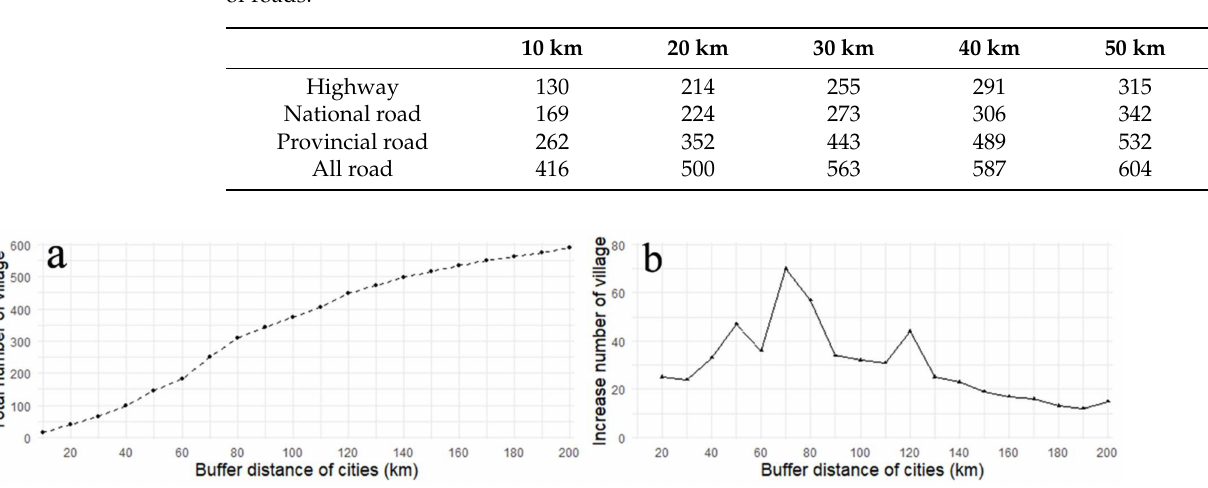
Figure 10. The relationship between the number of RT villages and the bufferdistance of cities: ( a ) total number of RT villages; ( b ) increase number of RT villages.